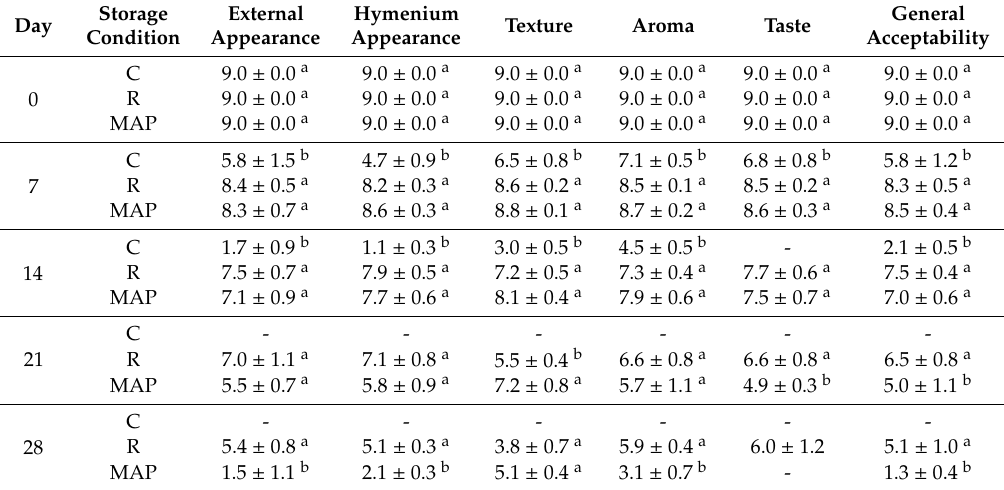
Table 2. Time trend of the sensory parameters of L. edodes under di ff erent storage conditions: room temperature (C), refrigerated at 4 ◦ C (R), and modified atmosphere packaging at 4 ◦ C (MAP). Each of the sensory attributes was scored on a 1–9 scale (1 = definitely unacceptable, 3 = unacceptable, 5 = may be acceptable, 7 = acceptable, and 9 = definitely acceptable). Data expressed as mean ± standard deviation (SD) of three